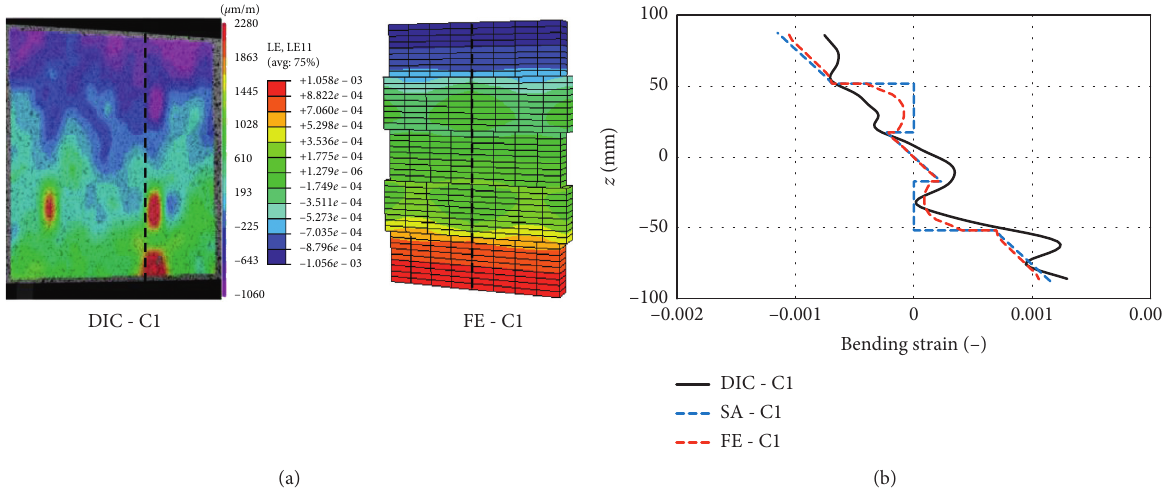
Figure 20: Colour contour plots and normal strain distribution from bending tests for C1.